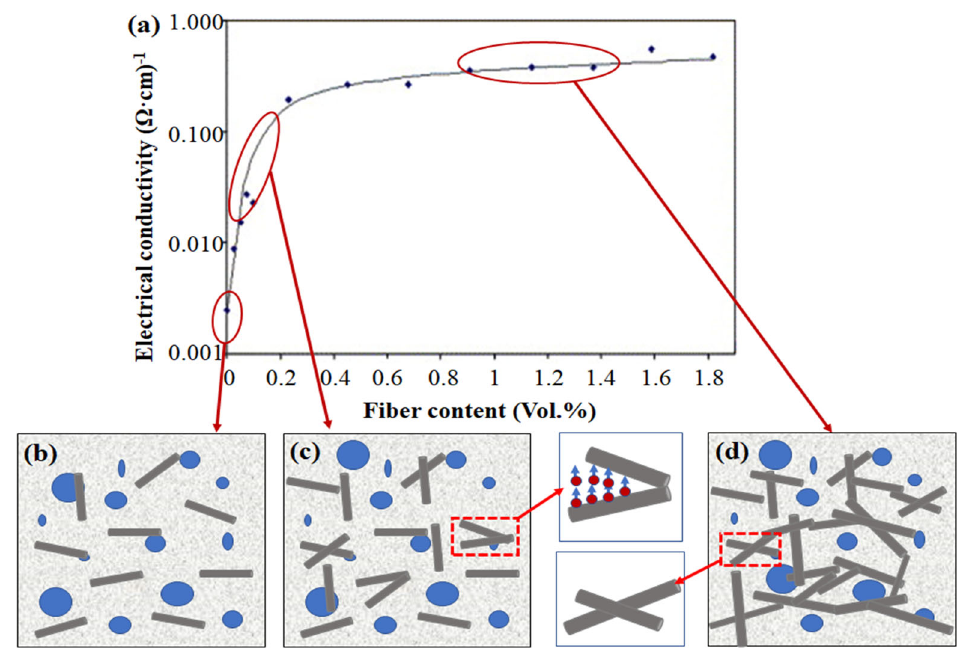
Figure 7. ( a ) Variation trend of electrical conductivity versus CF content [49] and ( b – d ) Conductive mechanism diagram of CFRC proposed by this paper.